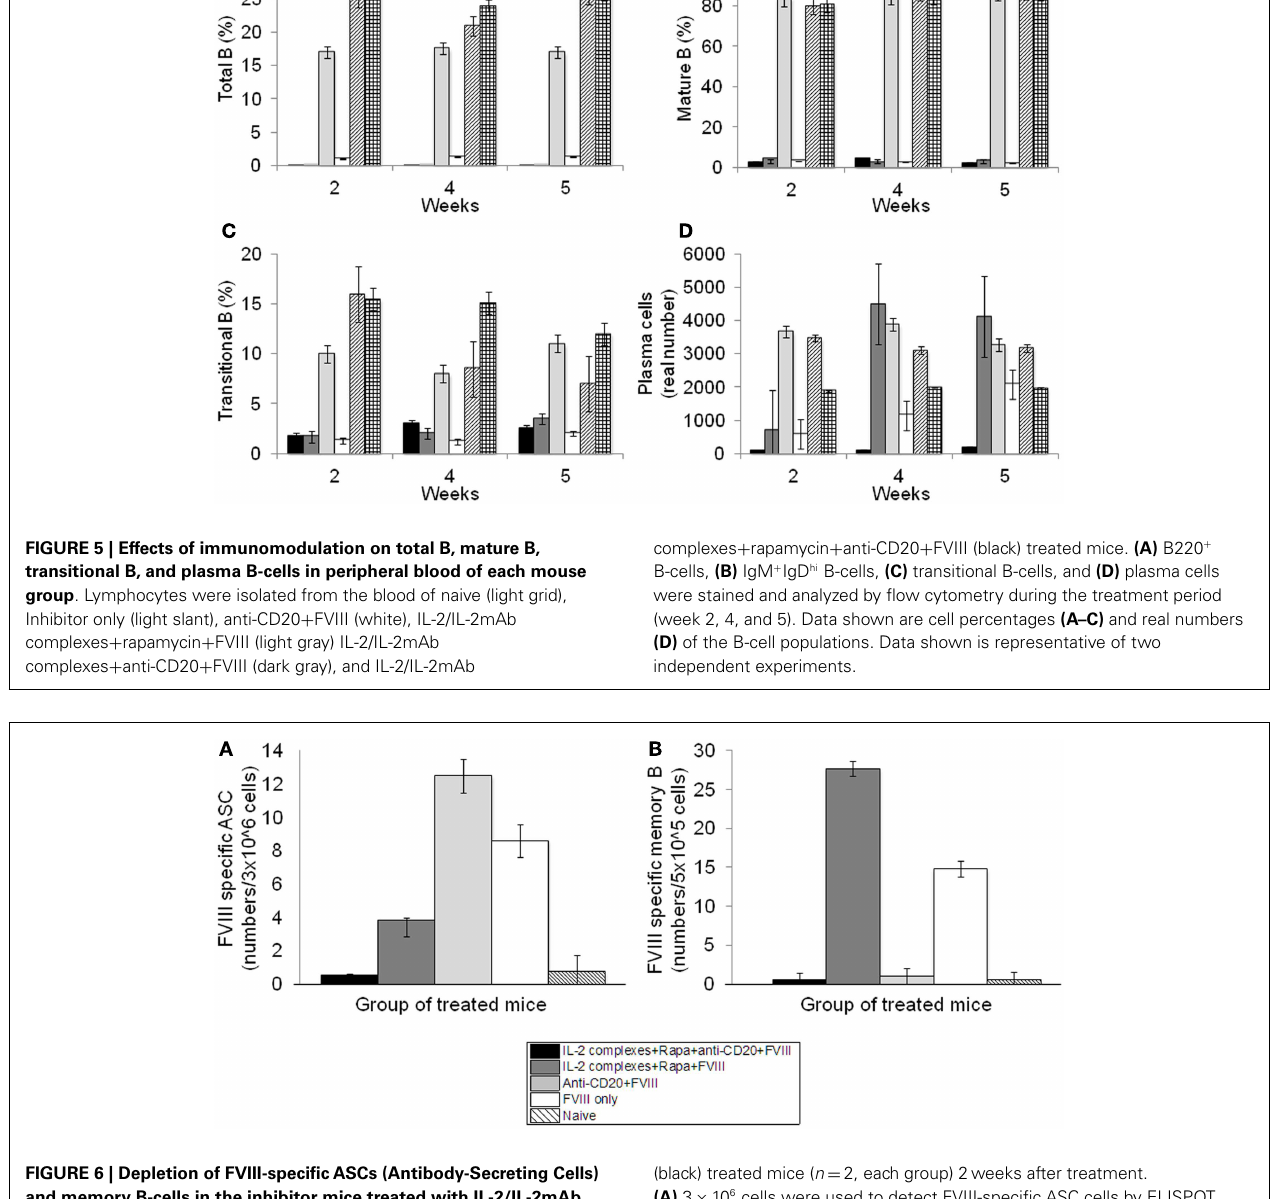
(black) treated mice ( n = 2, each group) 2weeks after treatment. (A) 3 × 10 6 cells were used to detect FVIII-specific ASC cells by ELISPOT assay. (B) 5 × 10 5 non-plasma cells were cultured and stimulated with FVIII at 10U/ml for 6-days, and memory B-cells were detected by ELISPOT assay. Data shown are mean of spot numbers for each treated group ( n =